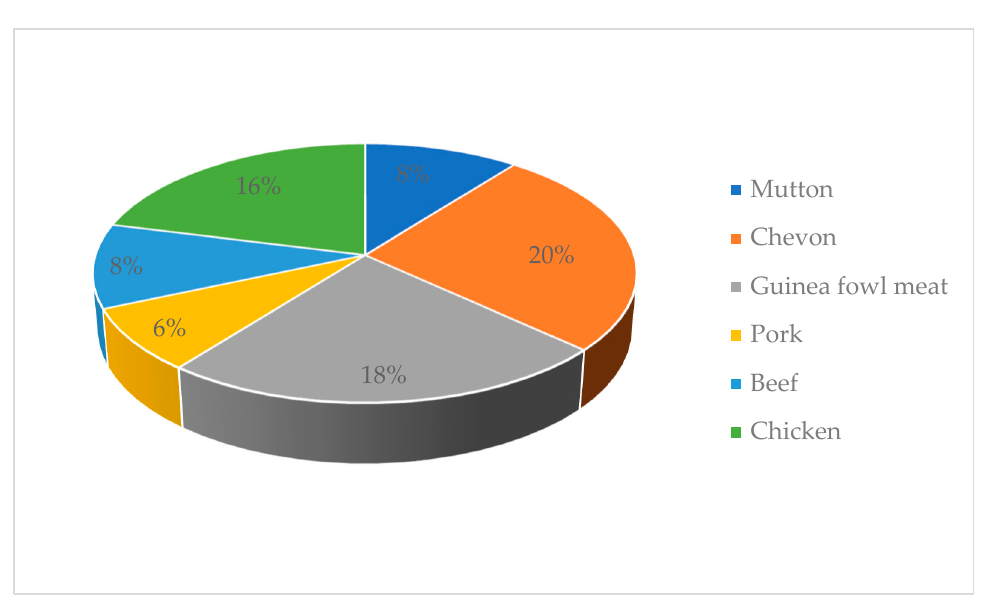
Figure 3. Prevalence of E. coli in ready-to-eat meats.